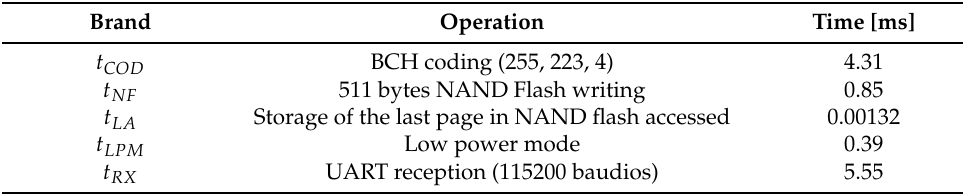
Table 4. Summary of times for writing in NAND Flash at 115200 baud